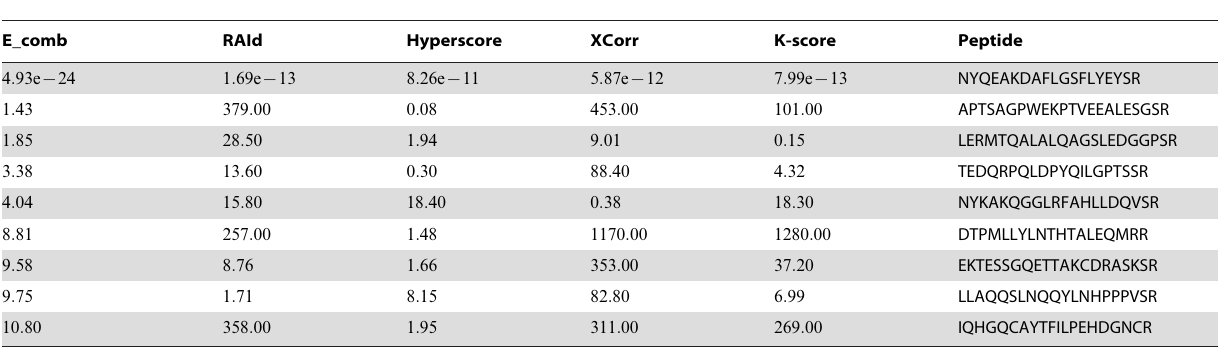
Table 1. An output example of the combined E-value from RAId_aPS.